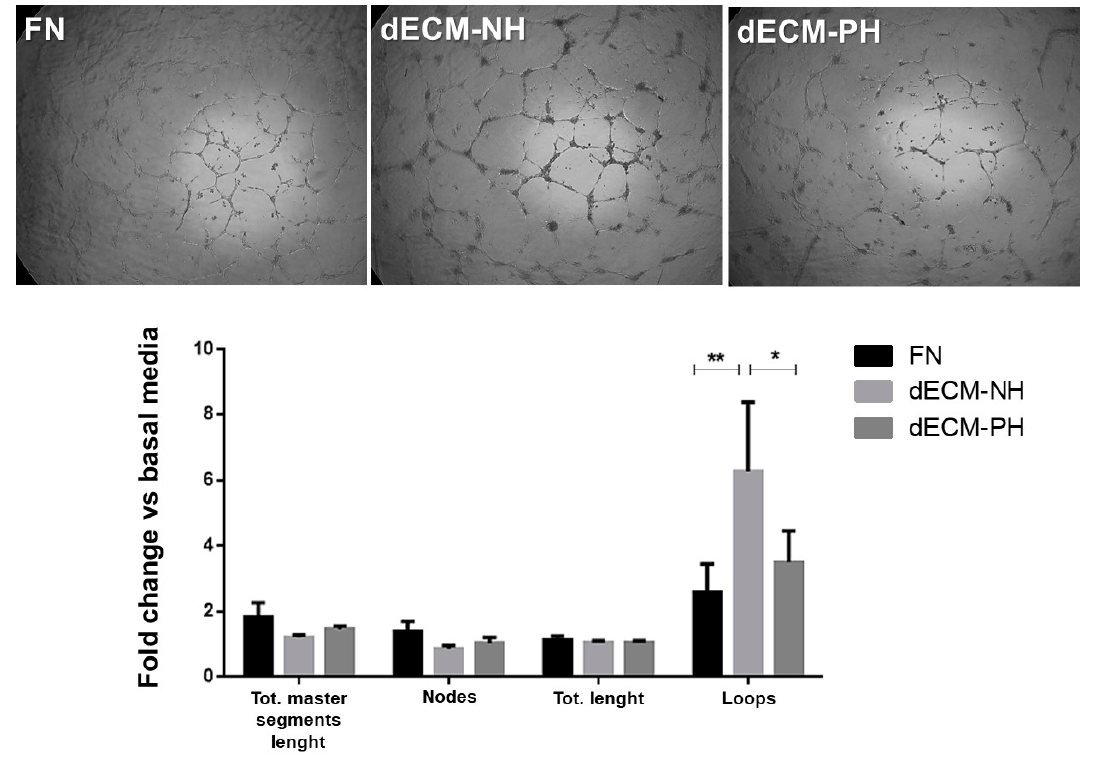
Figure 6. Analysis of pro-angiogenic potential of conditioned media from different substrates. Representative images are shown of human umbilical vein endothelial cells (HUVECs) plated on Matrigel for 18 hours, and differentially cultured in conditioned media by CPCs on fibronectin coating (FN), or on decellularized extracellular matrix (dECM) from normal hearts (NH) or pathological hearts (PH). Different features of HUVECs angiogenic capacity have been quantified by image analysis and plotted in the histogram: total master segments length, number of nodes, total tubes length, and number of closed loops. n = 8. *: p < 0.05. **: p < 0.01. Magnification 65×.